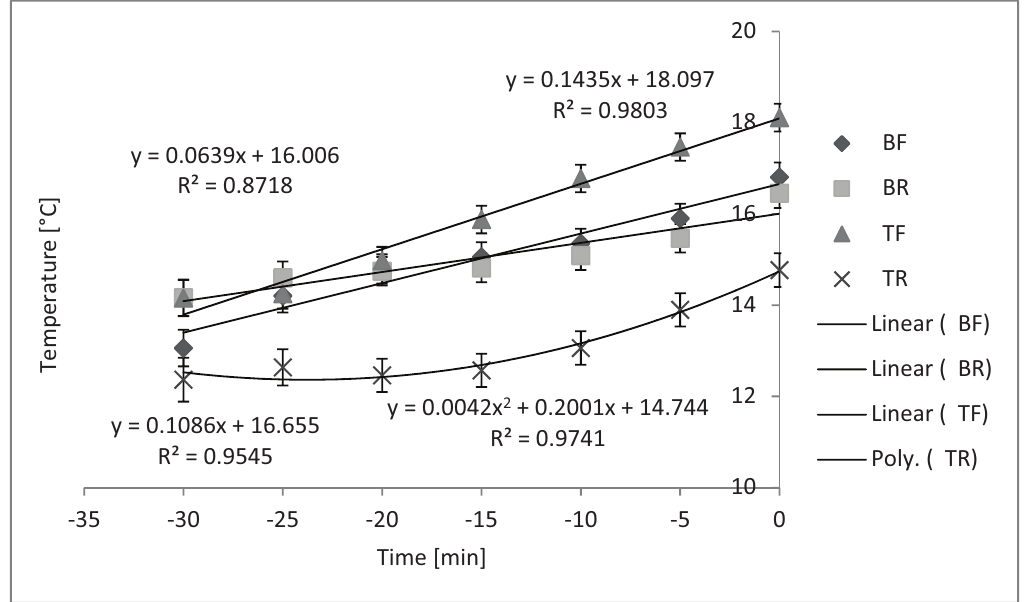
Figure 6. Compartment × time effect on internal trailer temperature while loading during mild weather (n = 21). Slopes of BF, BR and TR did not differ over time. Slope of TF was linear over time while loading in mild weather ( P = 0.02, SEb = 0.14).